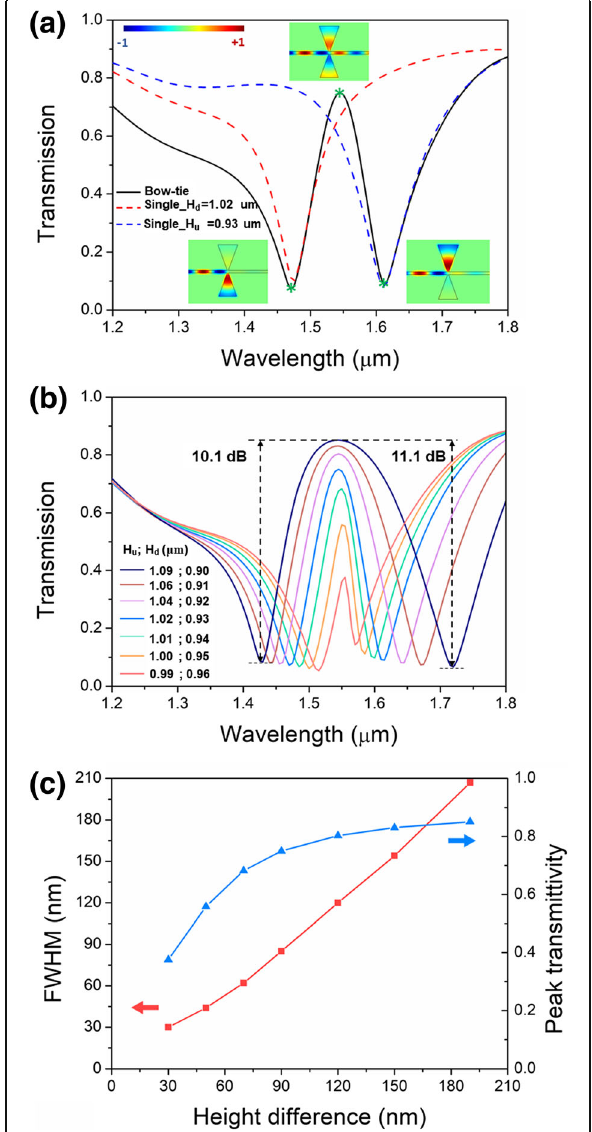
Fig. 4 PIT transmission of the asymmetric bowtie structure. a PIT Transmission spectrum. b PIT transmission spectra for varying height difference. c FWHM and peak transmittivity as functions of height